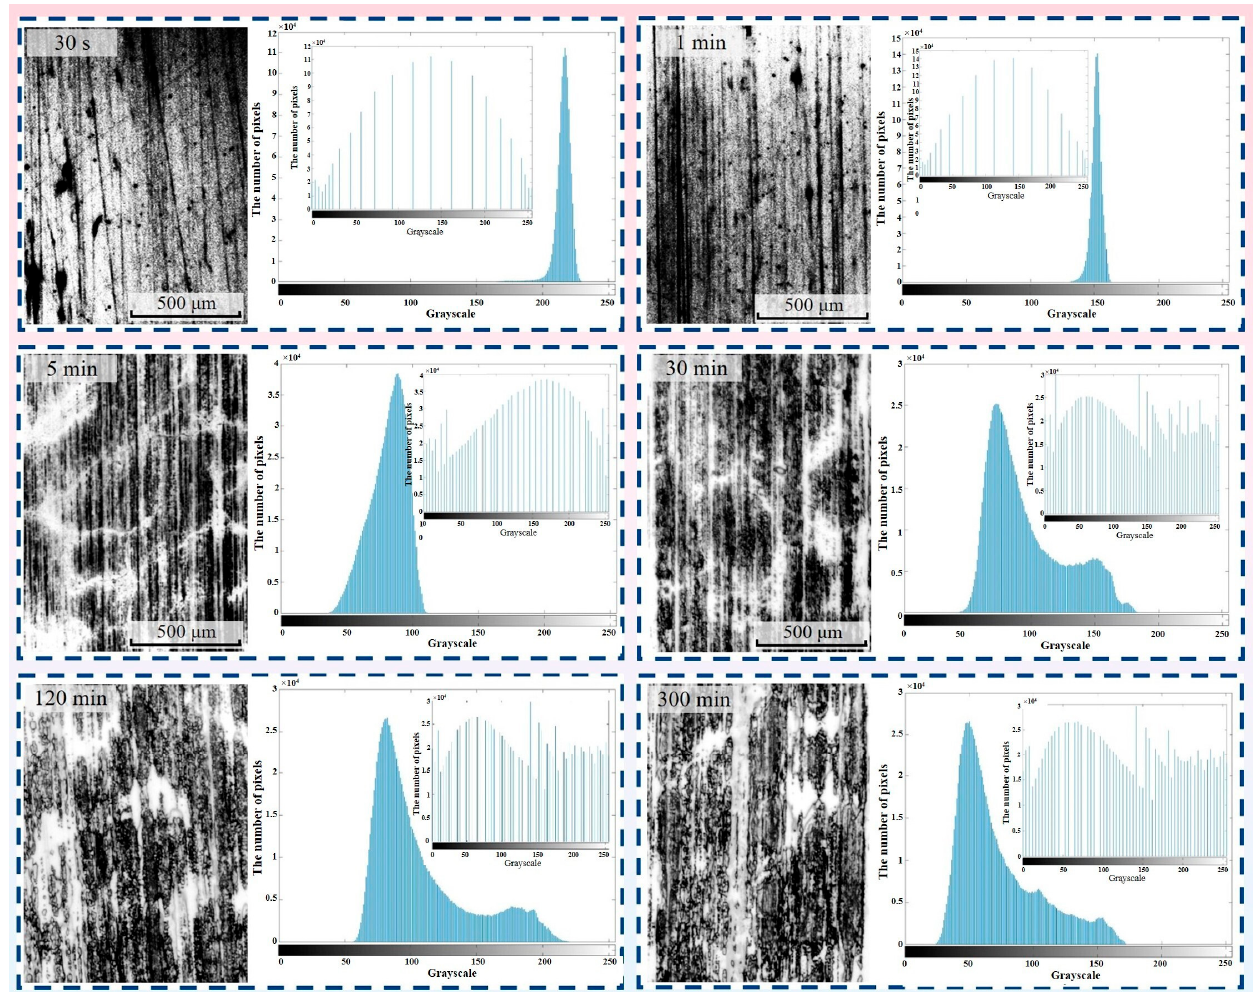
Figure 5. Histogram equalization of grey-scale images of transfer films.